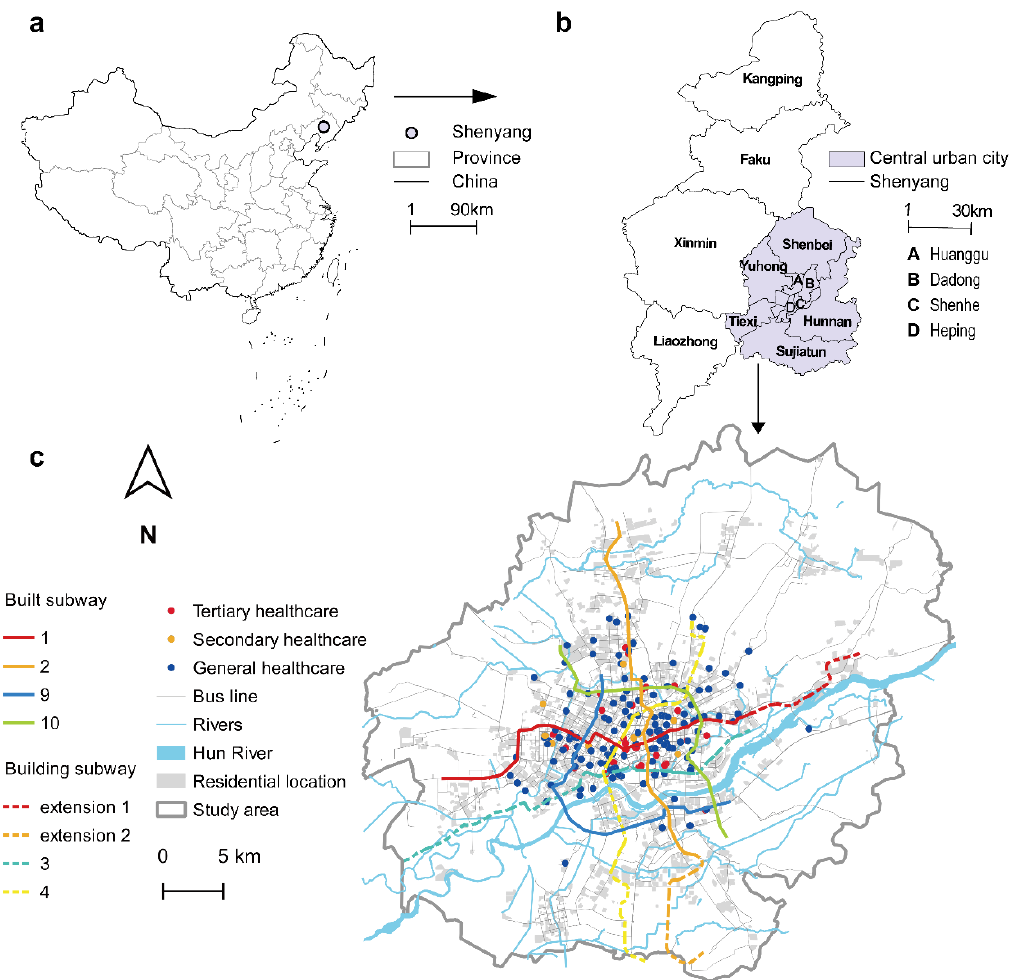
Figure 1. Spatial context of the central urban core of Shenyang: ( a ) location of Shenyang in China; ( b ) administrative boundaries in Shenyang; ( c ) overview of the study area.